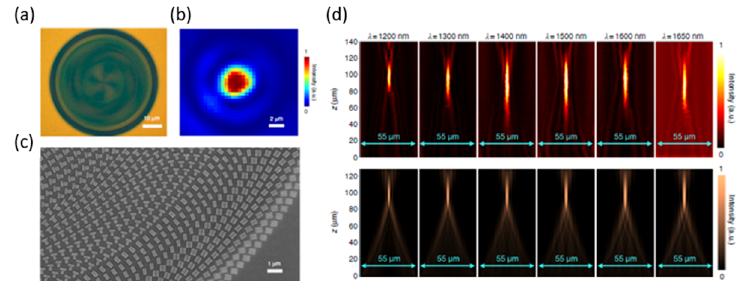
Figure 6. Verification of achromatic converging metalens. ( a ) Optical image of a fabricated metalens with NA = 0.268. ( b ) Measured light intensity of focal spot at incident wavelength λ = 1500 nm. ( c ) Zoomed-in scanning electron microscope (SEM) image of the fabricated metalens. ( d ) Experimental (top row) and numerical (bottom row) intensity profiles of BAML along axial planes at various incident wavelengths. (Reproduced from [35] with permission).